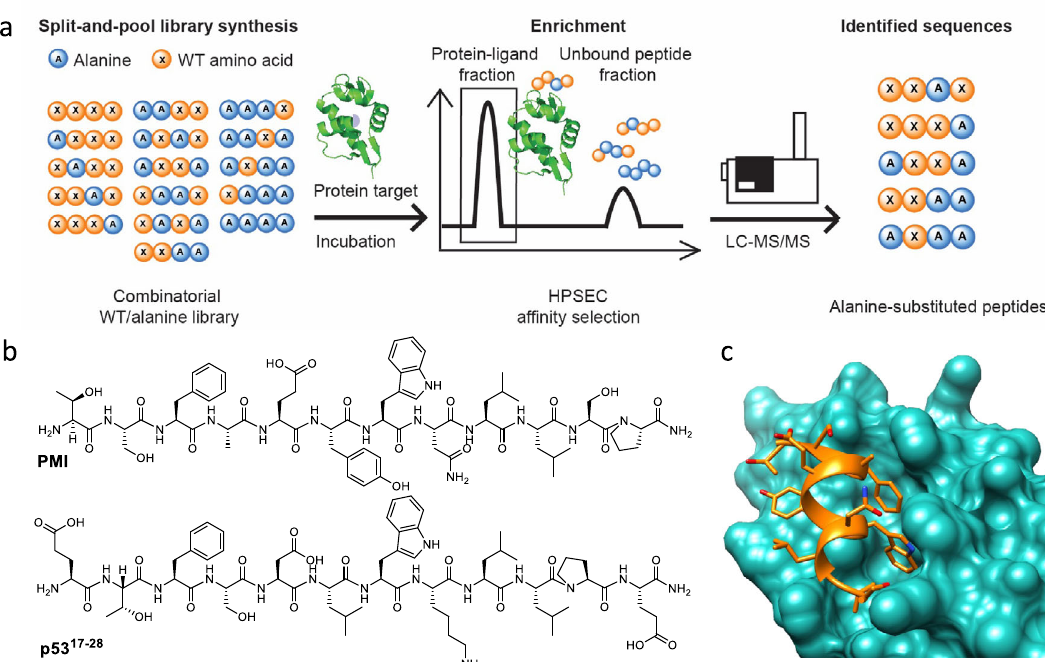
Fig. 1 Combinatorial alanine scanning enables identi fi cation of alanine-containing peptide binders to proteins of interest. a A chemically synthesized combinatorial alanine library was generated by split-and-pool solid phase peptide synthesis. The library was cleaved, deprotected, solid phase extracted, and incubated with protein targets. The peptide – protein complex eluate was separated from unbound peptides by size-exclusion chromatography. Bound peptide binders were dissociated from the protein and then sequenced by Q-TOF liquid chromatography-tandem mass spectrometry (LC-MS/MS). b Chemical structure of p53 17 – 28 peptide (ETFSDLWKLLPE-OH) and PMI (TSFAEYWNLLSP-NH 2 ). c Crystal structure of the PMI – MDM2 complex (TSFAEYWNLLS-NH 2 , PDB entry 3LNZ) 23 .